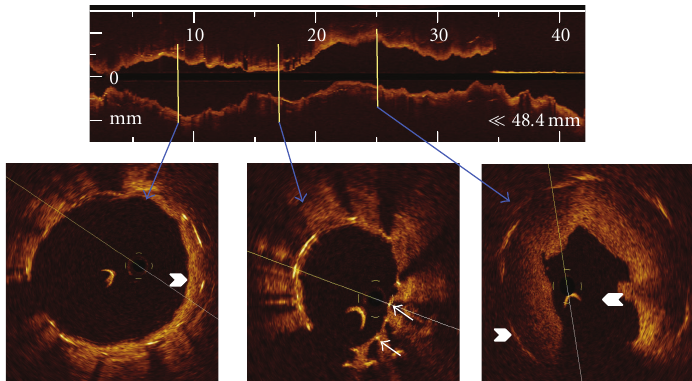
Figure 2: Optical coherence tomographic (OCT) images during pullback from distal (a) to proximal (c) segments. OCT showed severe focal stent underexpansion (b) localized in the overlapping segment, where two struts layers are visible (arrows) and fragments of in-stent remnant thrombus (arrowheads) after balloon